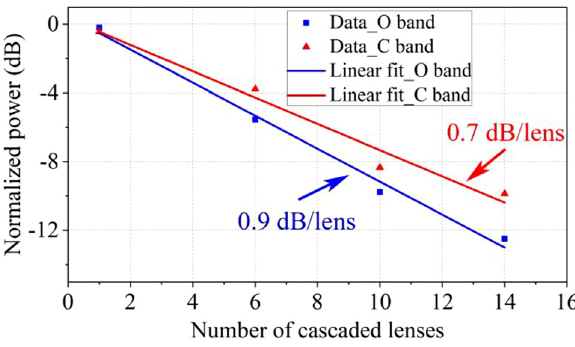
Figure 8: Insertion losses of cascaded on-chip half Maxwell’s fisheye lenses.